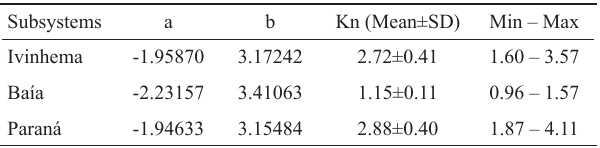
Table 5. Values of the length-weight relationship parameters and relative condition factor ( Kn ) of Hemiodus orthonops between the three subsystems of the upper Paraná River floodplain. a = intercept, b = slope, Kn = relative condition factor, SD = standard deviation, Min = minimum, Max =